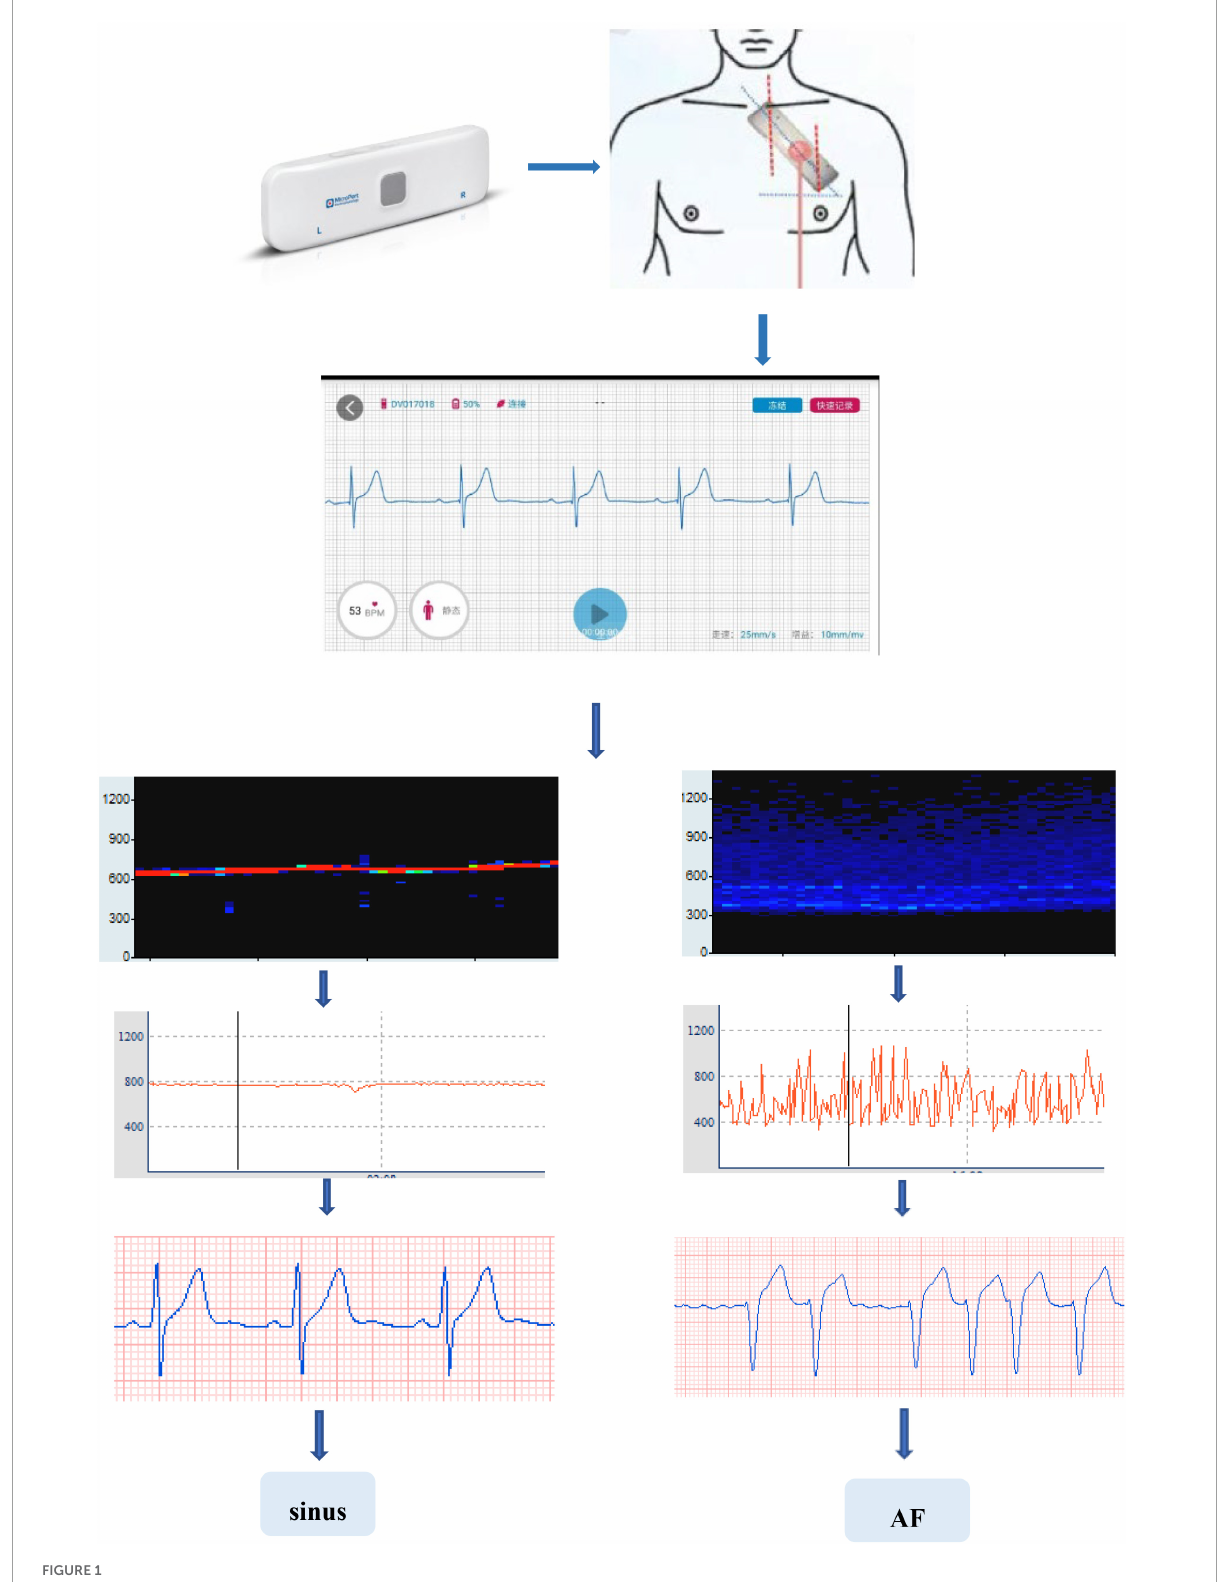
FIGURE1 Work flow of portable long-time single-lead ECG monitor and